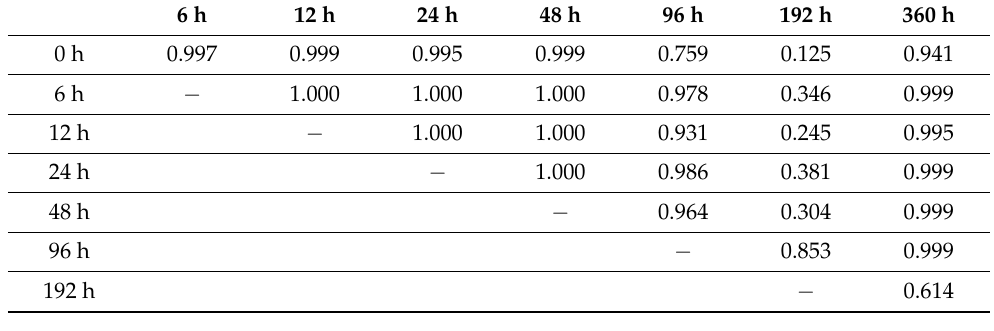
Table 3. p -values of the different groups of duration of UV irradiation. Table 3. p-values of the different groups of duration of UV irradiation.